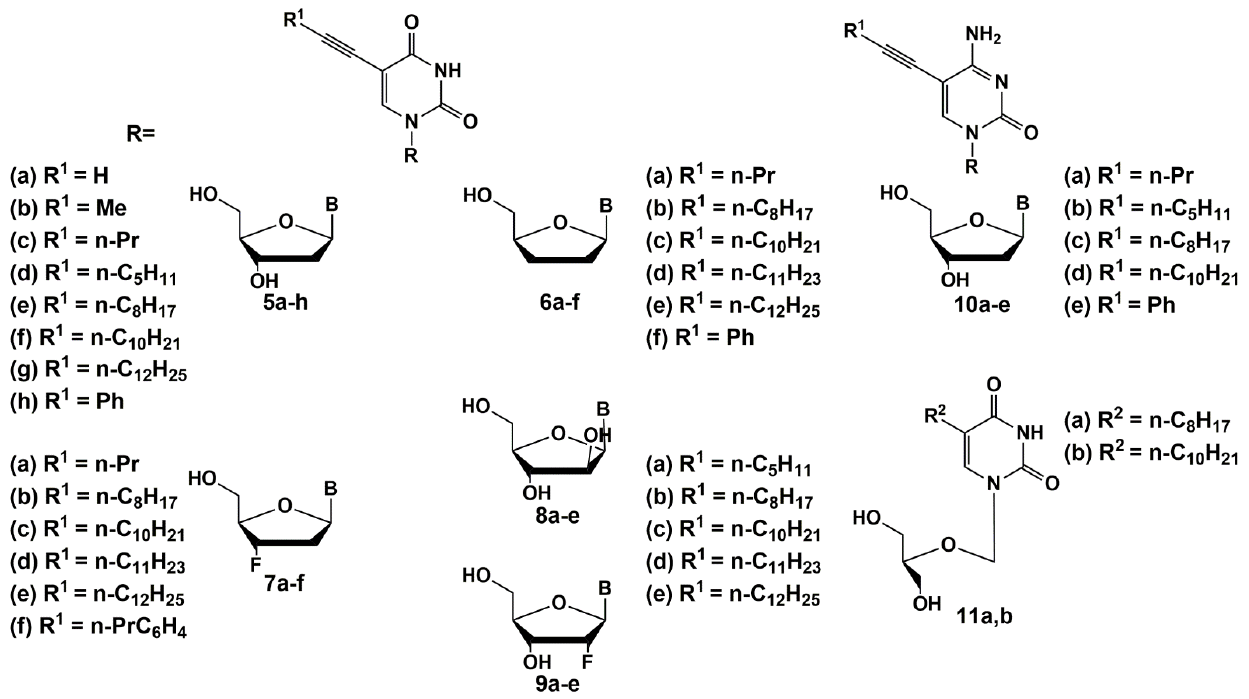
Figure 2. С -5 alkynyl derivatives of pyrimidine nucleosides. Figure 2. C-5 alkynyl derivatives of pyrimidine